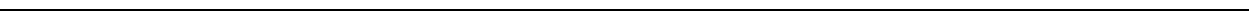
Fig. 3 Sch9 kinase activity is disturbed in cells lacking Ssb. a , b FLAG-IP reactions were performed with extracts derived from Δ sch9 cells overexpressing either Sch9 ( − FLAG) or Sch9-FLAG (+FLAG). If indicated ATP was added at a concentration of 10 mM. Total extracts (input) and immunoprecipitated proteins (FLAG-IP) were separated on Tris-Tricine gels and were subsequently analyzed via immunoblotting using α -Sch9, α -Ssb, and α -Maf1. Details are described in Methods section and in Supplementary Fig. 3a, b. c , d Maf1 phosphorylation is reduced in Δ ssb1 Δ ssb2 cells. Strains as indicated were grown on glucose (+glucose) or were depleted for glucose for 10 min ( − glucose) prior to collection. Strains labeled with Sch9 ↑ overexpress Sch9. Protein extracts were analyzed via phos-tag gels followed by immunoblotting with α -Maf1. M0: dephosphorylated Maf1 species, M1: hyper-phosphorylated Maf1 species. λ P: lambda phosphatase treated extract. e Protein levels of Sch9 and Maf1 are unaffected in cells lacking Ssb. Extracts from glucose-grown strains were resolved on a Tris-Tricine gel and were subsequently analyzed via immunoblotting with α -Maf1, α -Sse1, α -Ssb, or α -Sch9. The numbers below the Maf1 bands indicate the intensity of the total Maf1 signal in Δ ssb1 Δ ssb2 cells relative to that in wild-type cells. f Maf1 hyper-phosphorylation requires phosphorylation of Sch9-T737 and the Ssb co-chaperone RAC. Protein extracts from indicated strain were analyzed via phos-tag gels followed